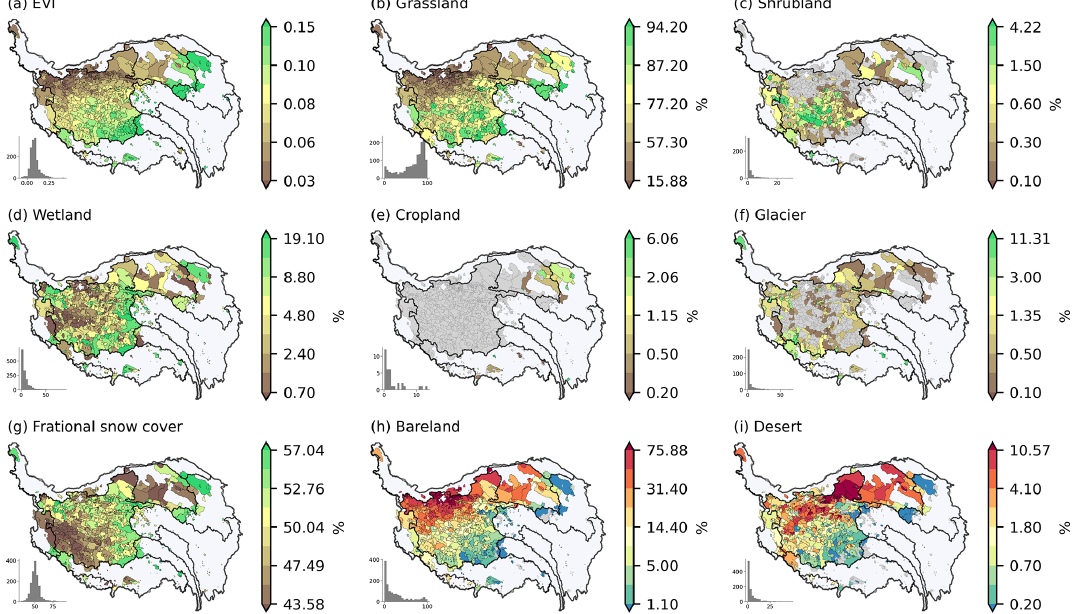
Figure 9. Spatial distribution of land use/cover characteristics for inter-lake catchments on the TP. The multi-year average EVI from 2000 to 2021 and the land use/cover type and fraction in 2015 are shown in the